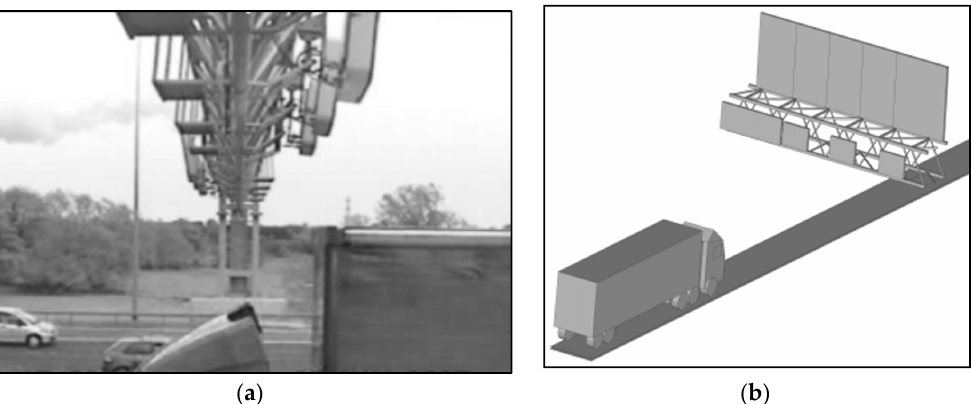
Figure 10. ( a ) Typical passage of an HSV under portal gantry for field study [39] and ( b ) CAD model of HSV and partial gantry boom.